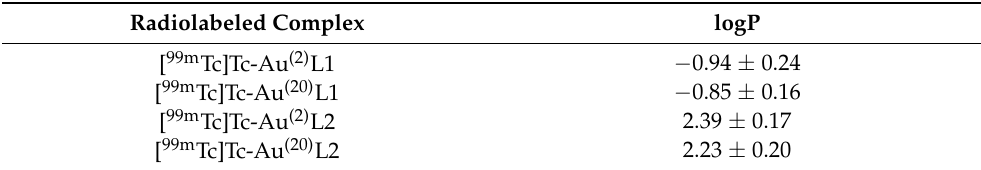
Figure S3: HPLC Diagrams representing the in vitro stability of [99mTc]Tc-Au(2)L1 in histidine solution at (A) 1 h and (B) 24 h post-incubation, Figure S4: HPLC Diagrams representing the in vitro stability of [99mTc]Tc-Au(2)L1 in human serum at (A) 1 h and (B) 24 h post-incubation, Figure